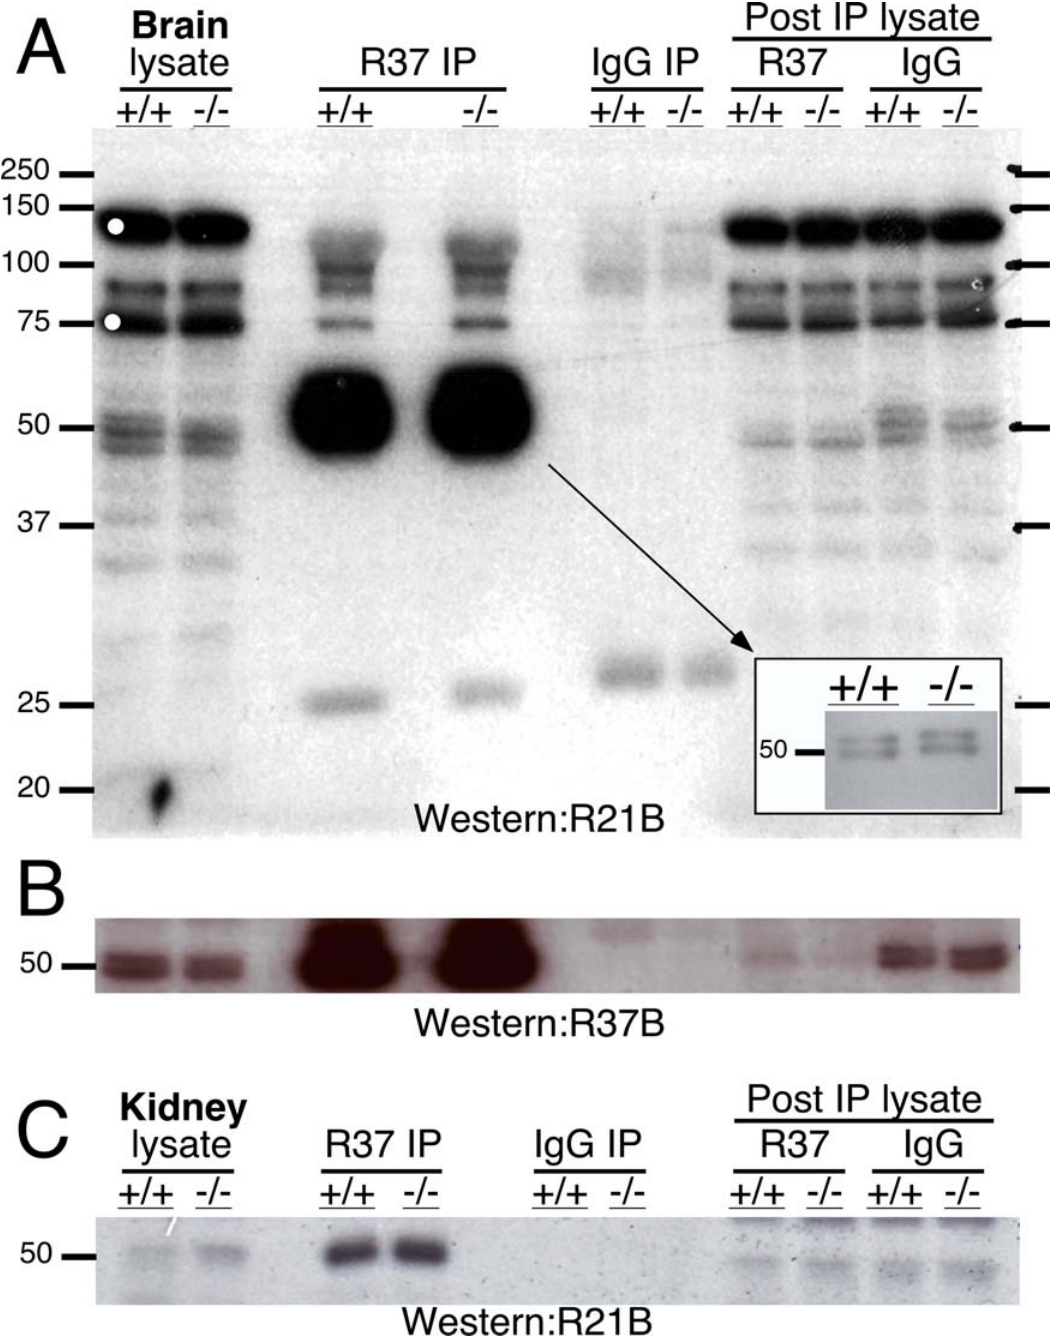
Figure 2. Somatic sAC isoforms unaffected in Sacy tm1Lex locus. Immunoprecipitations (IP) using mAb R37 or IgG control antibody from detergent solubilized whole cell extracts (lysates) of brains (A,B) or kidney (C) from wild type or Sacy tm1Lex /Sacy tm1Lex mice were subjected to Western analysis using (A,C) biotinylated R21 mAb (R21B) or (B) biotinylated R37 mAb (R37B). White circles denote nonspecific bands detected with streptavidin (no primary antibody) alone. The smear at , 50 kDa in the R37 IP from brain resolves to at least two bands when less of the IP is loaded for Western blotting (inset).